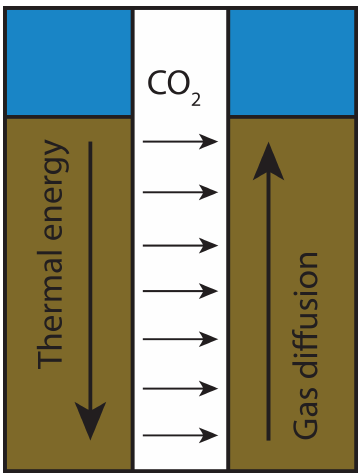
Figure 1. Thermal and gas diffusion lags through a soil